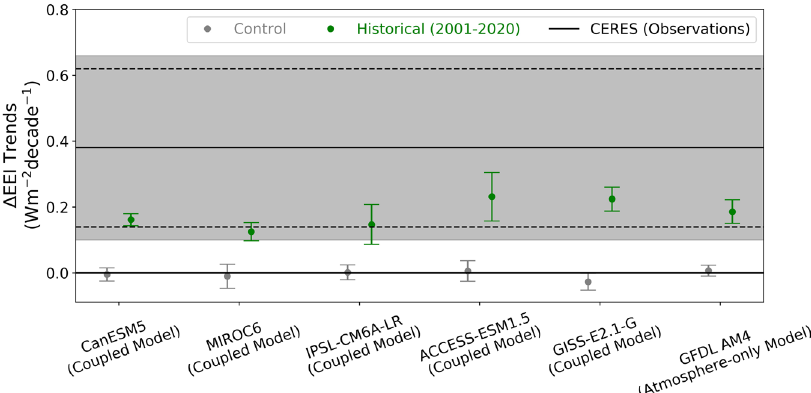
Fig. 4 Global-mean observed trend in Earth ’ s energy imbalance (EEI) obtained by anthropogenic forcing and the associated climate response. Trends in Δ EEI (TEEI) with 95% con fi dence intervals (CI) ( Δ represents anomalies). Dashed lines indicate Clouds and the Earth ’ s Radiant Energy System (CERES) TEEI ’ s 95% CI derived from observational uncertainty and standard error of linear fi t (internal variability). Shading indicates CERES TEEI ’ s 95% CI with internal variability uncertainty estimated from model-derived ϵ . The lower end indicates the minimum contribution by anthropogenic forcing and the associated climate response ( Δ ERF + λ Δ T s ; see Eq. 1) to CERES TEEI. Conversely, the upper end indicates the maximum anthropogenic contribution to CERES TEEI. Geophysical Fluid Dynamics Laboratory Atmosphere Model 4 (GFDL AM4) ‘ Historical ’ value represented by the experiment with prescribed sea surface temperatures and sea ice and effective radiative forcing changes (forcing agents varying) (AM4 PSST + ERF). Control experiments denoted by light gray fi lled circles. Historical experiments denoted by green fi lled circles. CanESM5 = Canadian Earth System Model version 5, MIROC6 = Model for Interdisciplinary